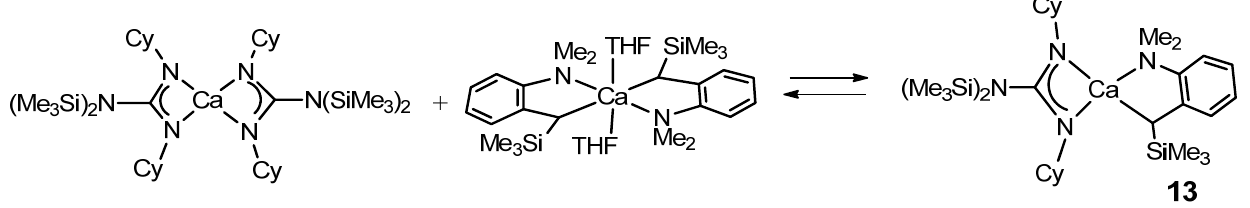
Figure 8. Magnesium magnesioamidinato complex.